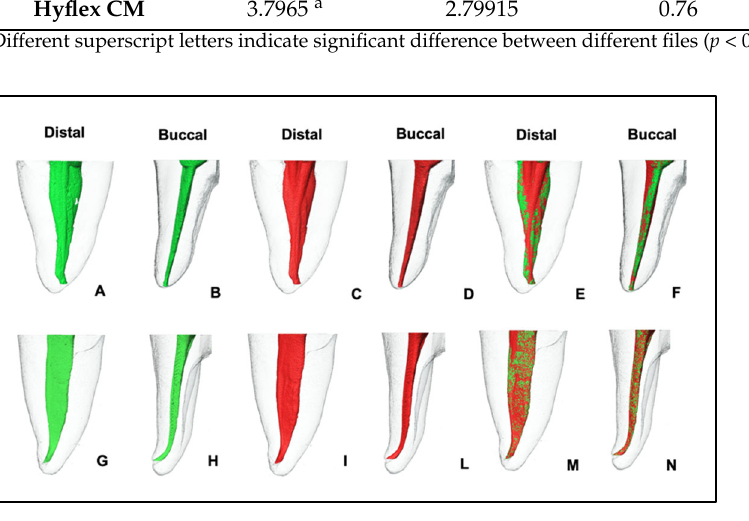
Table 3. Percentage of untouched areas by 2Shape and HyFlex CM rotary instrumentation. Percentage of Untouched Areas (%) Instrument Mean